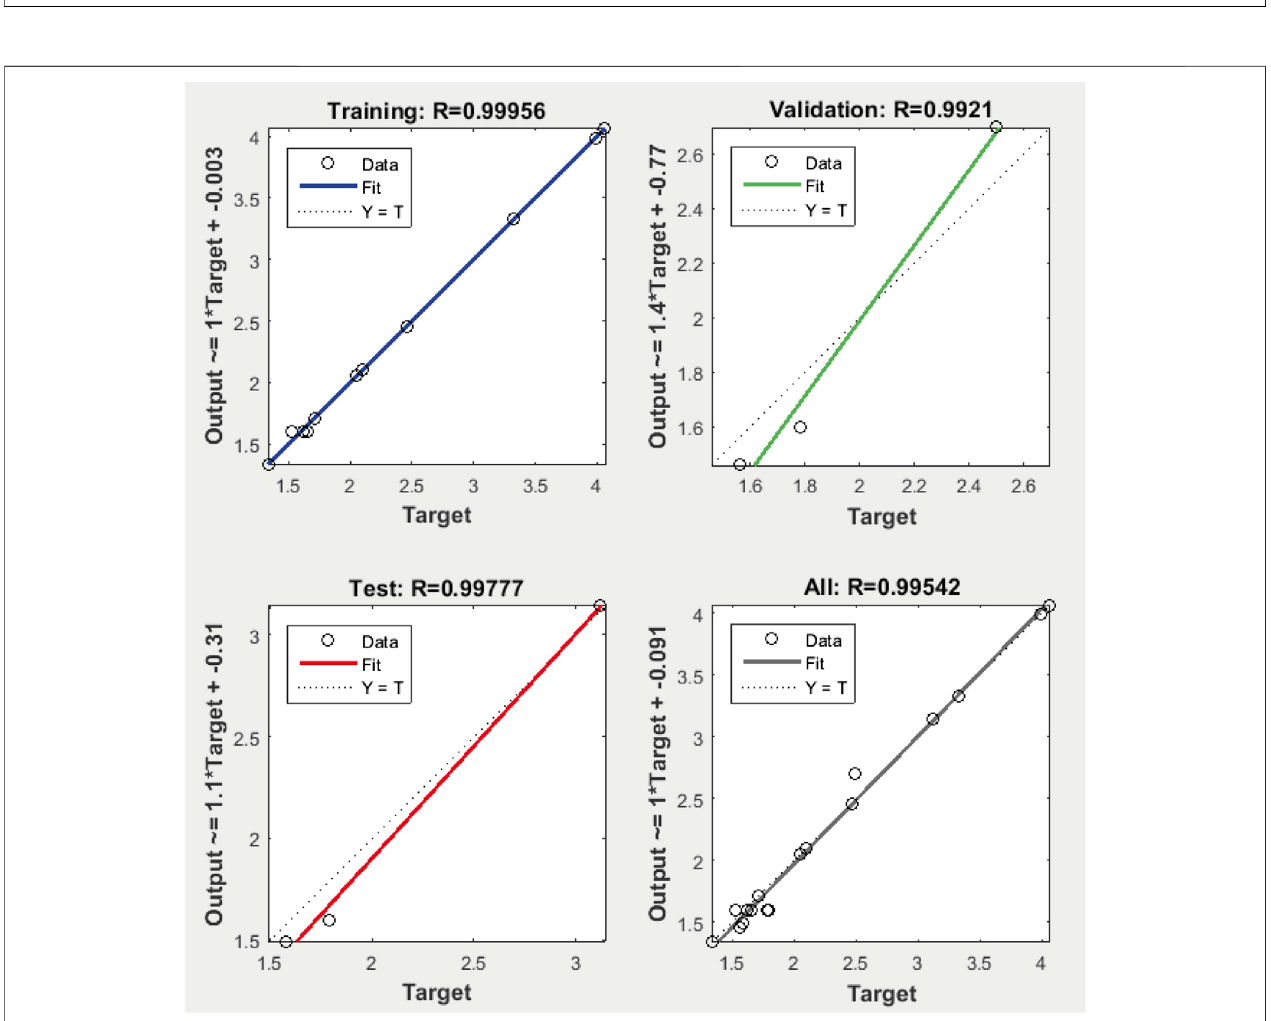
FIGURE 7 | Correlation plots of predicted versus experimental values for the ANN